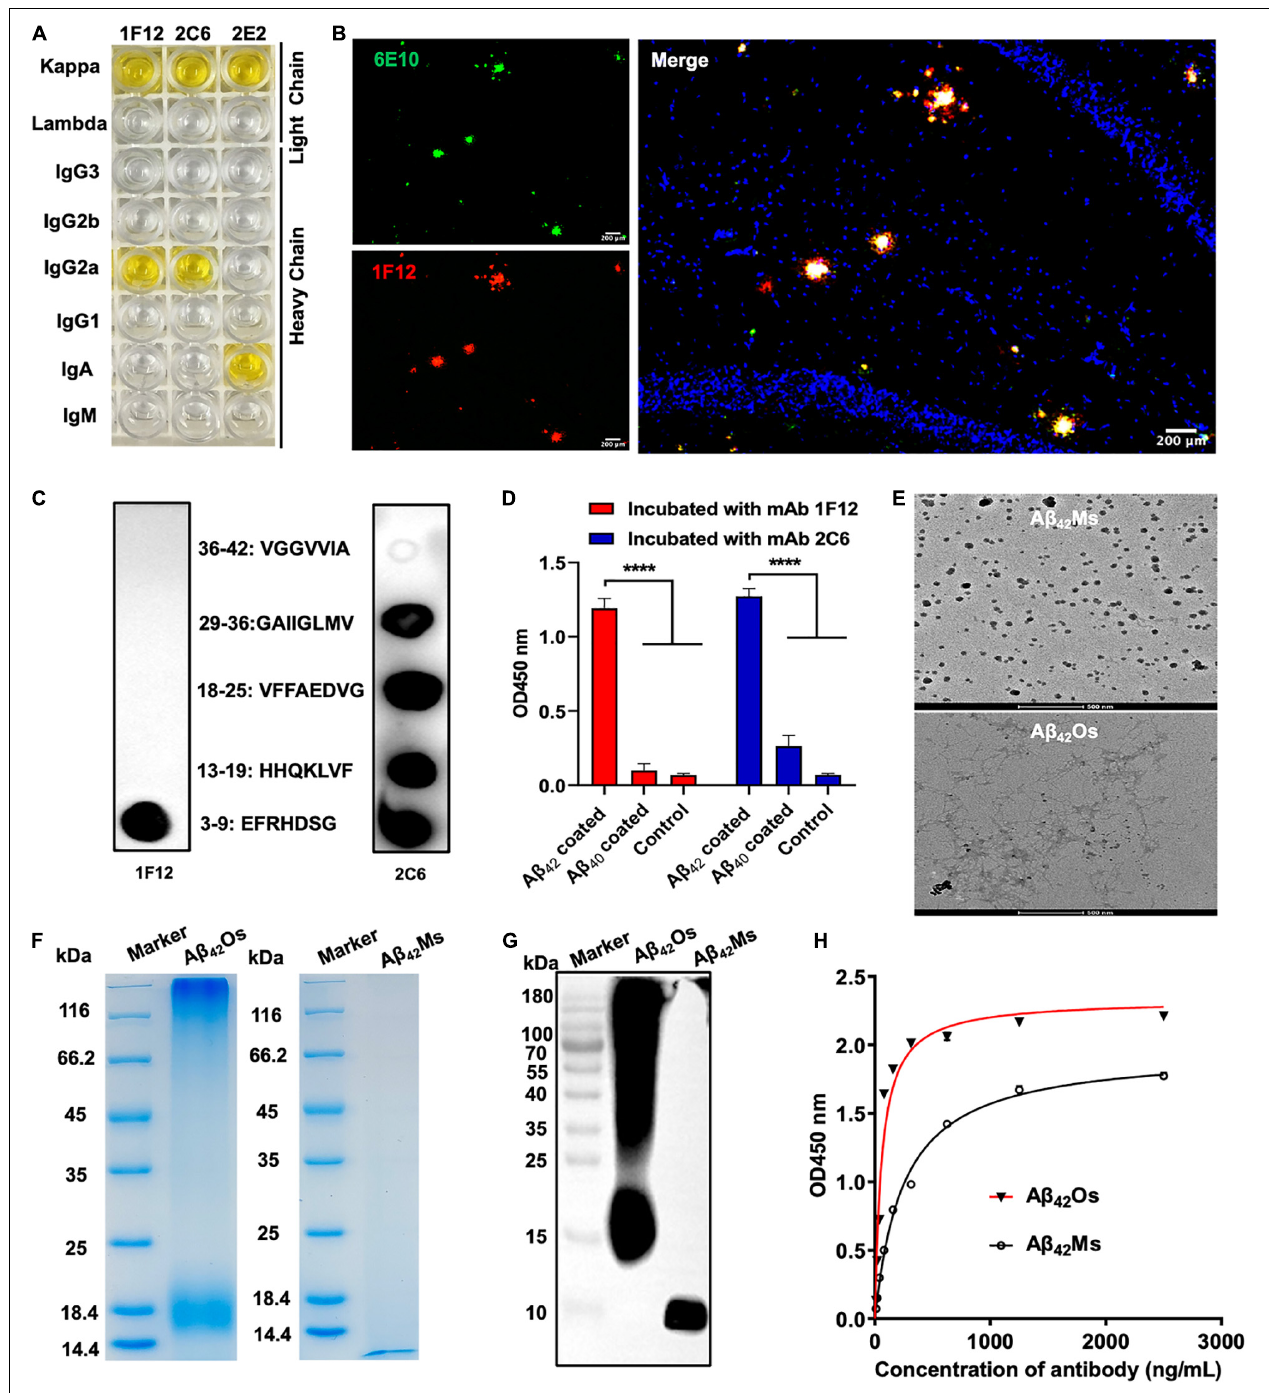
FIGURE 1 | Characterization of sequence and conformation-specific antibodies for A β 42 Ms and A β 42 Os. (A) The isotypes of the prepared monoclonal antibodies. (B) Confocal fluorescence images of murine APP/PS1 brain sections using Cy3-labeled anti-A β 42 monoclonal antibody 1F12 and commercially available anti-A β antibody 6E10. (Scale bar: 200 µ m). (C) Linear epitopes of A β 42 recognized by 1F12 and 2C6. (D) The binding affinities of 1F12 and 2C6 to A β 42 and A β 40 were determined by indirect ELISA. (E) The morphologies of A β 42 Ms and A β 42 Os were analyzed by cryo-transmission electron microscopy in parallel. (Scale bar: 500 nm). The purity and molecular weight of freshly prepared A β 42 Ms and A β 42 Os were determined by 12% reduced SDS-PAGE using Coomassie blue staining (F) and Western blotting with 1F12 (G) . (H) The K d value of 1F12-binding A β 42 Ms and A β 42 Os was detected with indirect ELISA. Data are presented as means ± SEM. One-way analysis of variance (ANOVA) was used for multigroup comparisons. Statistical significance is indicated in the figures by **** p < 0.0001.